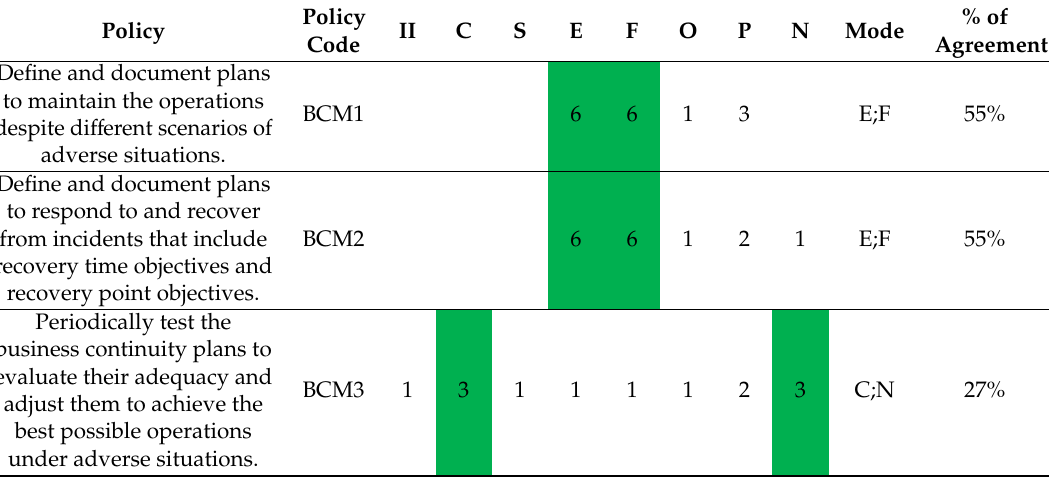
Table 27. Business continuity management policies’ progression